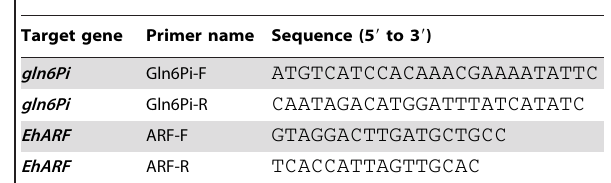
Table 1. RT-PCR primers used in this